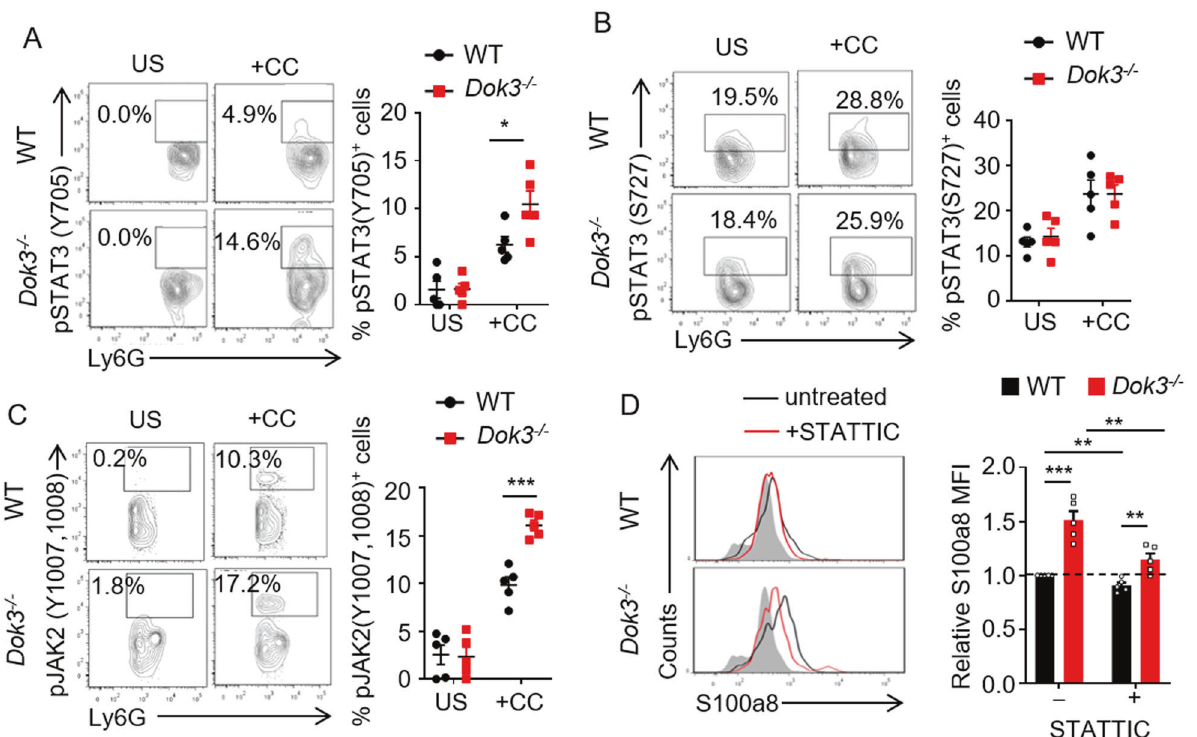
Fig. 5 DOK3 suppresses JAK2-STAT3 signaling in neutrophils. A – C Lamina propria cells from WT and Dok3 − / − mice were unstimulated (US) or stimulated for 10 min with cecal contents ( + CC) from wild-type mice. Flow cytometric analysis of A pSTAT3 (Y705), B pSTAT3 (S727) and C pJAK2 (Y1007, 1008) in colonic neutrophils ( n = 5, four independent experiments). Contour plots were pre-gated on singlet, CD45 + , Ly6G + cells. Data is shown as mean ± SEM. A * p = 0.03, unpaired two-tailed Student ’ s t -test. C *** p = 0.0002, unpaired two-tailed Student ’ s t -test. D Cells from lamina propria of WT and Dok3 − / − mice were stimulated for 3 h with cecal contents from wild-type mice in the absence (black histogram) or presence (red histogram) of STATTIC. Flow cytometric analysis of S100a8 expression in WT and Dok3 − / − colonic neutrophils. Histograms were pre-gated on singlet, CD45 + , Ly6G + cells. Filled histogram represents isotype control. Bar graph depicts MFI of S100a8 fl uorescence in WT (black bars) and Dok3 − / − (red bars) neutrophils treated or not with STATTIC relative to that of untreated WT neutrophils. Data is shown as mean ± SEM ( n = 5, four independent experiments). ** p = 0.008, 0.007, 0.005 (from left to right), *** p = 0.0002, unpaired two- tailed Student ’ s t